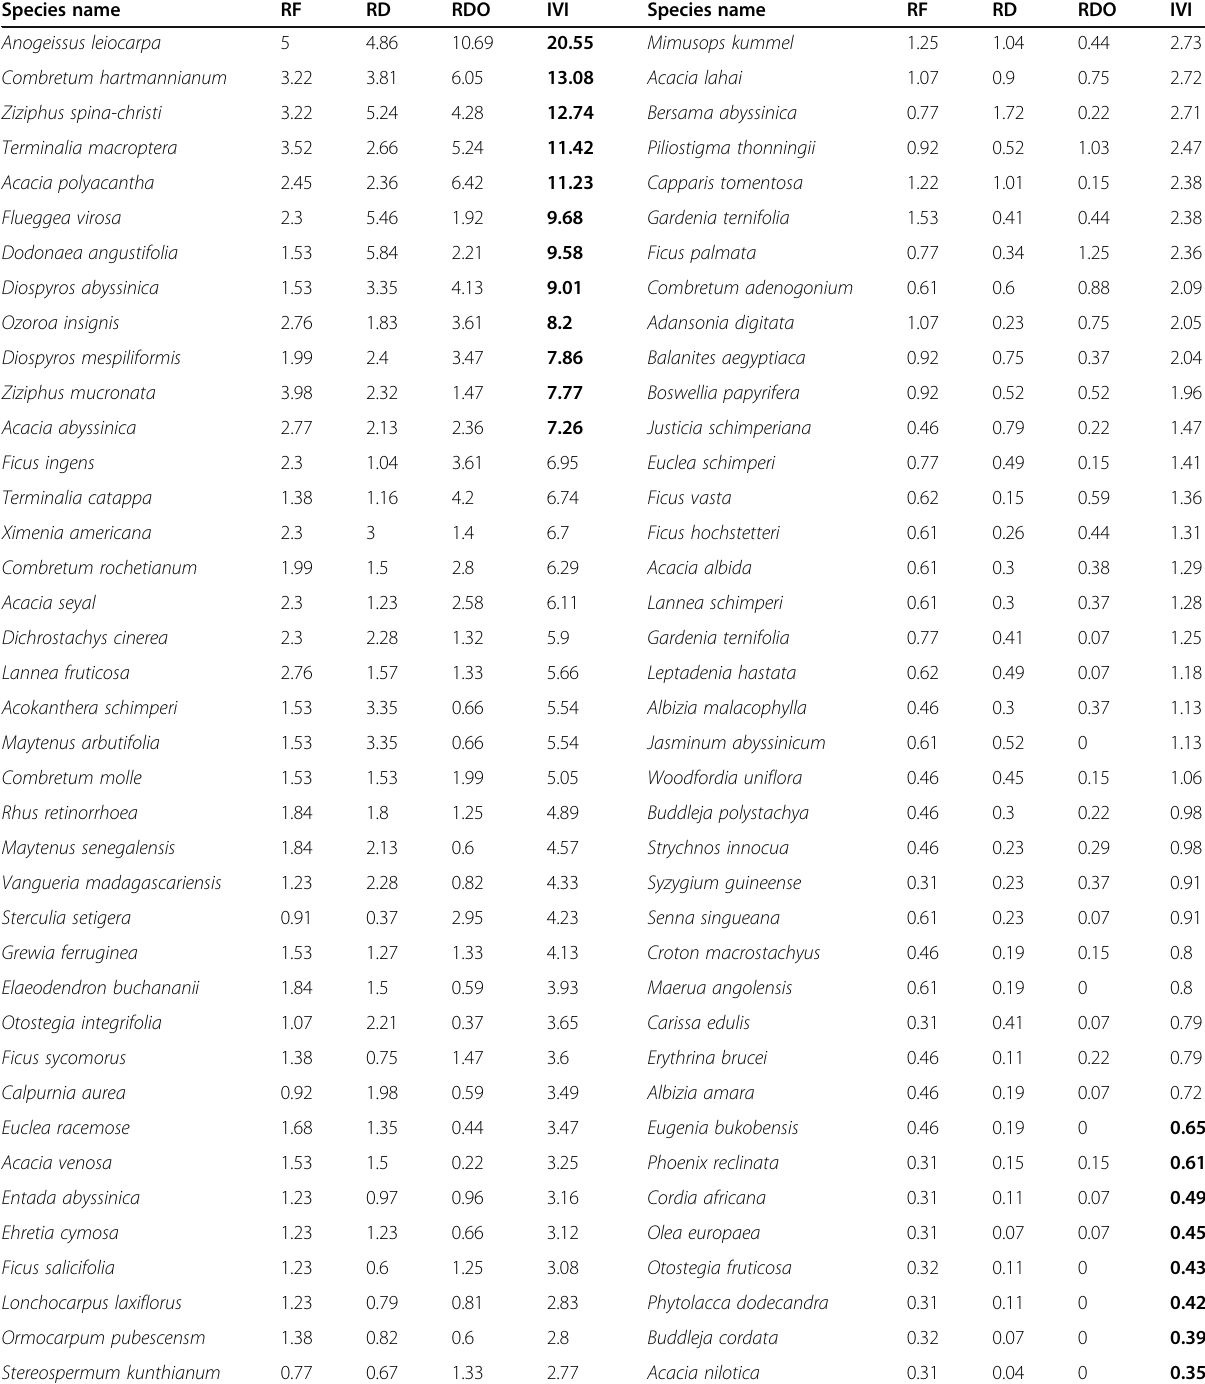
Table 5 Important value index of woody species of the Hirmi woodland